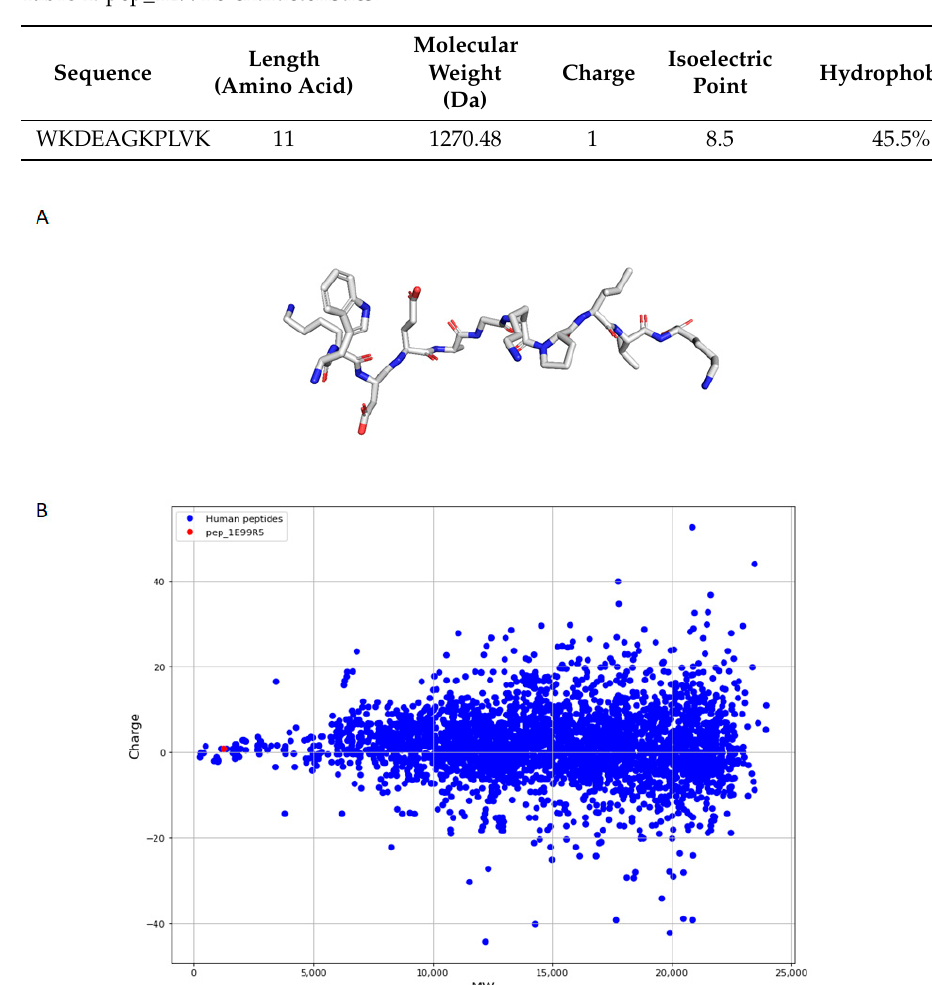
Figure 6. Linear representation of pep_1E99R5 and molecular weight and charge dispersion of pep_1E99R5 compared to endogenous human peptides. ( A ) Representation of the linear structure for pep_1E99R5 generated using PyMol, Version 2.3.5, Schrödinger, LLC (stick visualisation). ( B ) Dispersion of molecular weight and charge of human endogenous peptides (blue) and pep_1E99R5 (red). The human peptides were retrieved from UniprotKB (https://www.uniprot.org/statistics/Swiss-Prot (Accession date: 8 March 2021)) and filtered with a threshold of 200 amino acids. The average molecular weight of the human peptides is 14.4 kDa (Q1 = 11.3 kDa, Q3 = 18.1 kDa) while pep_1E99R5 is 1.3 kDa. The average charge of the human peptides is +2.9 (Q1 = − 1, Q3 = +7) while pep_1E99R5 ′ s charge is +1.